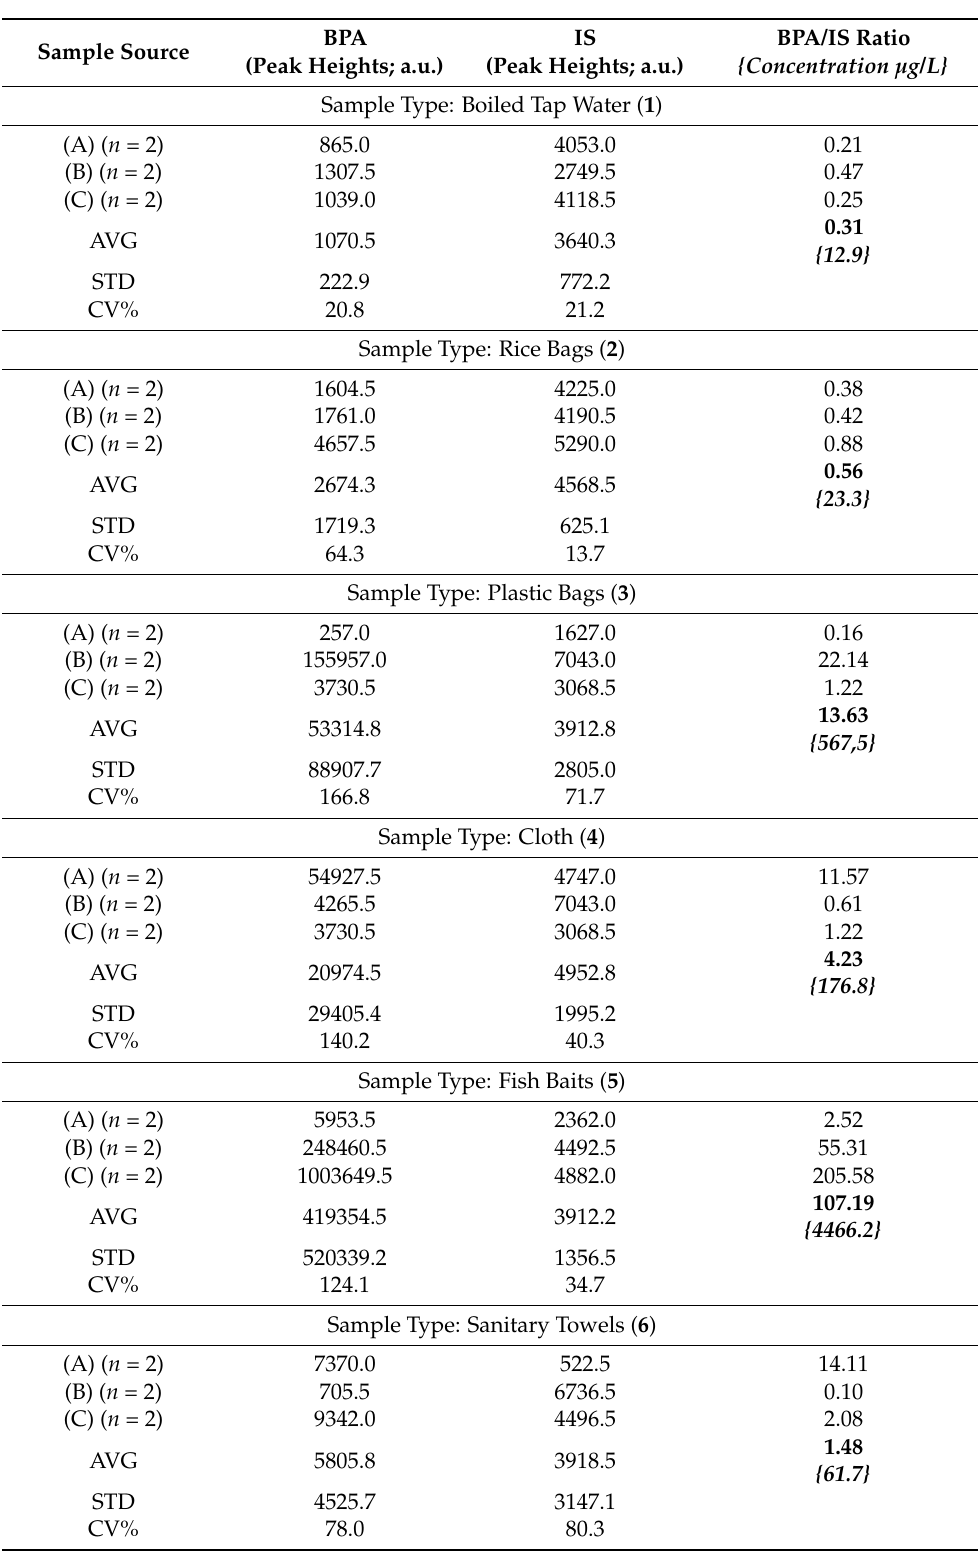
Table 6. Quantitative data (values of peak heights and bisphenol A/internal standard ratio) for all samples